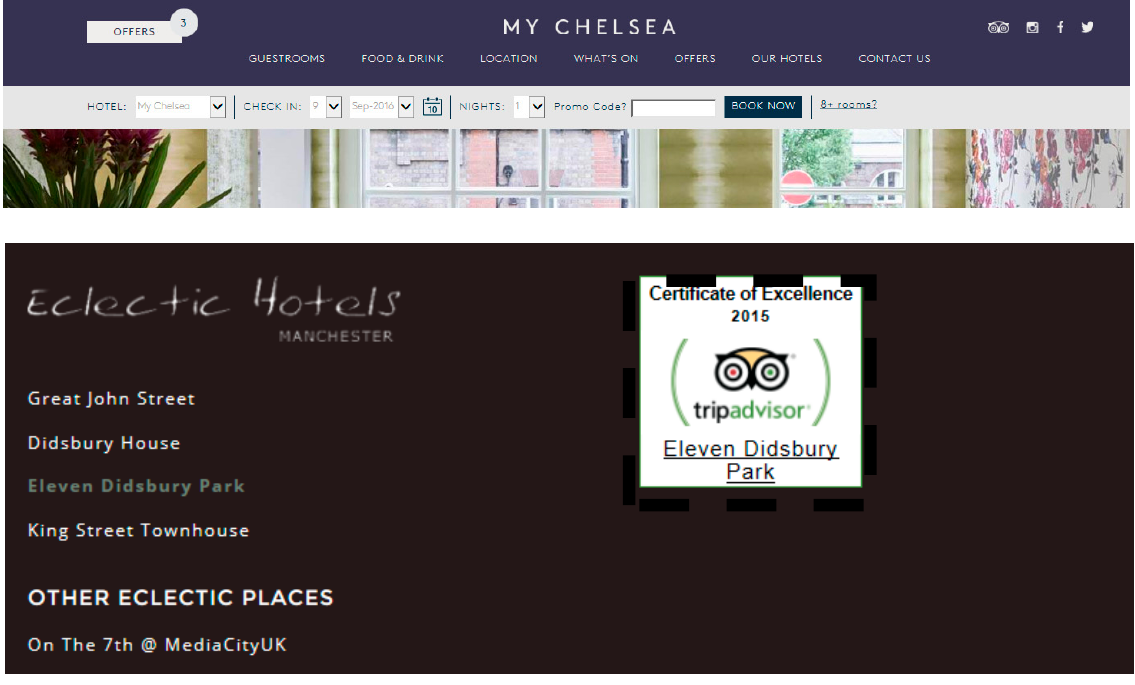
Figure A3. A specific claim to TripAdvisor reviews and performance on the website are made via an inbuilt section of the website.